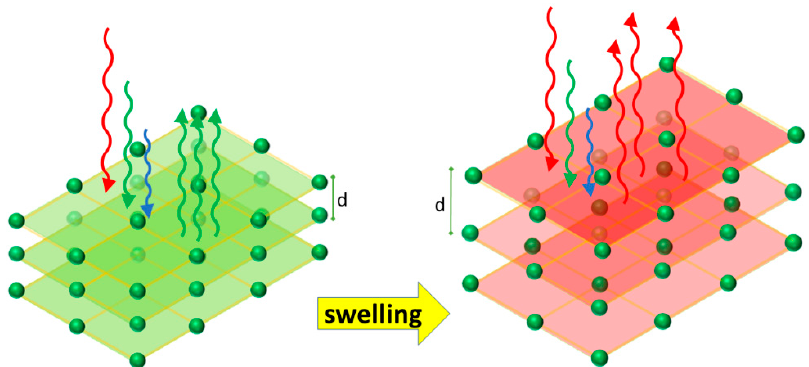
Figure 4. Change of the optical chromatic response, moving from green to red, of a 3D photonic crystals sensor due to an increase of the interplanar distance.